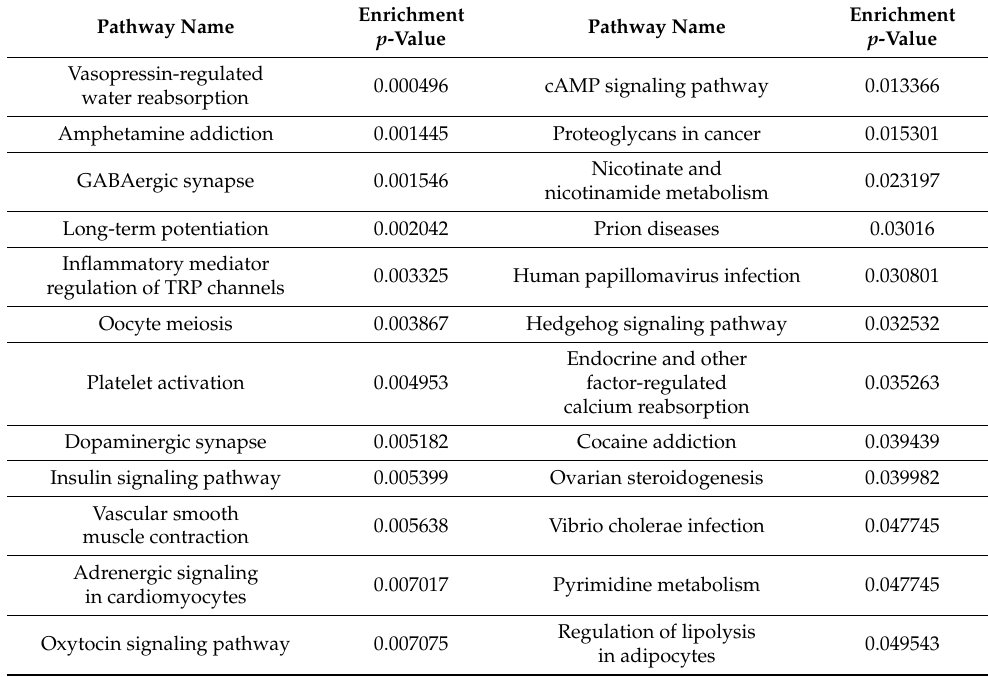
Table 2. The predicted pathway of less abundant salivary protein in Streptococcus pneumoniae group than Influenza A